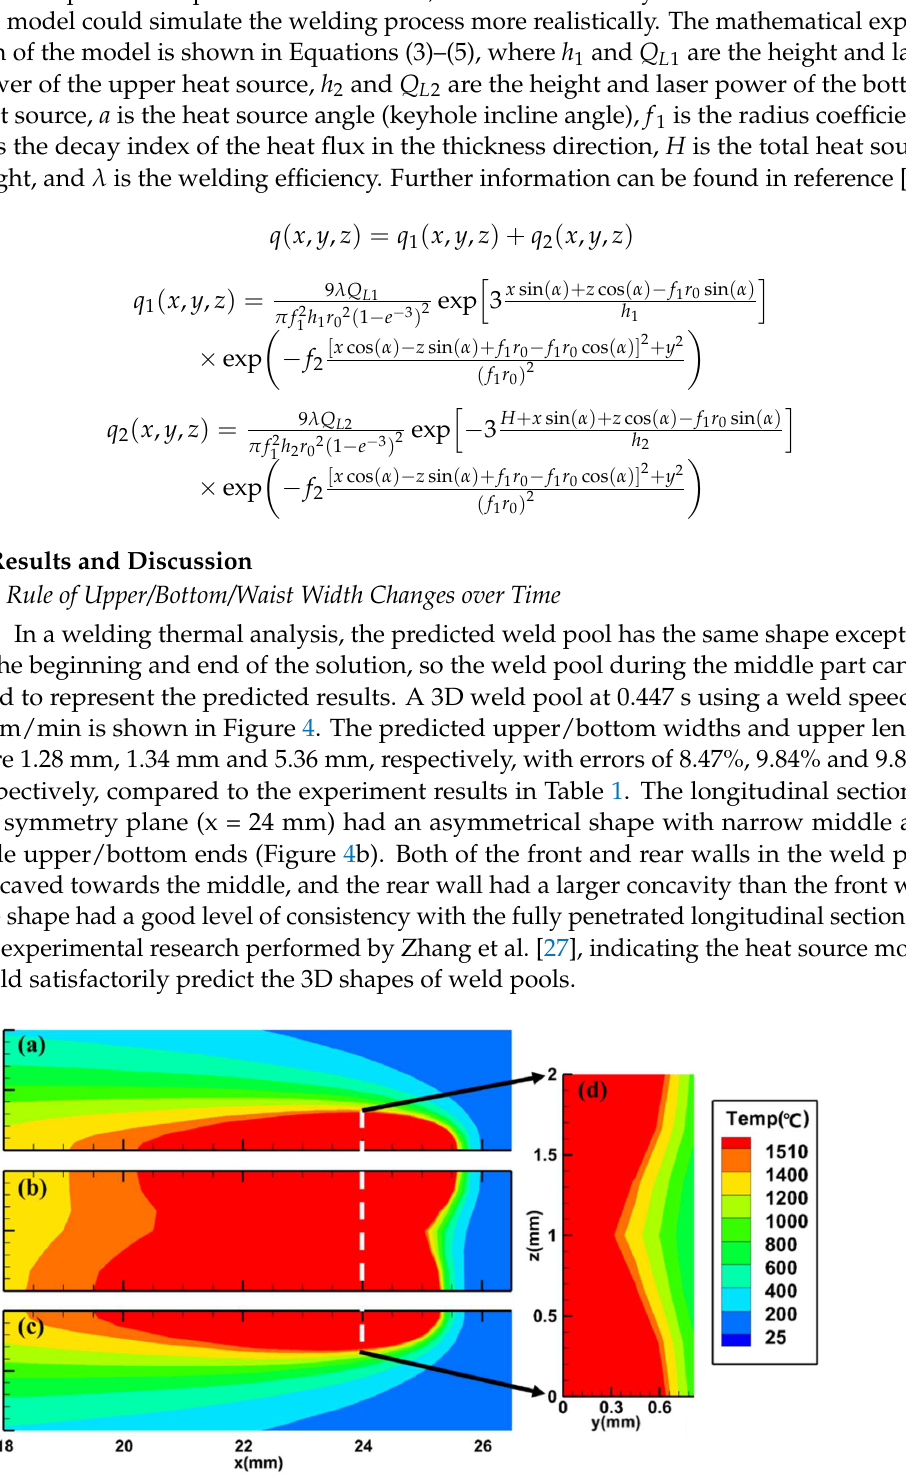
Figure 4. Images showing the 3D weld pool at 0.447 s: ( a ) upper surface, ( b ) longitudinal section at the symmetry plane y = 0 mm, ( c ) bottom surface and ( d ) cross section at the plane x = 24 mm. In terms of validation, the difference between the predicted and experimental WCSs